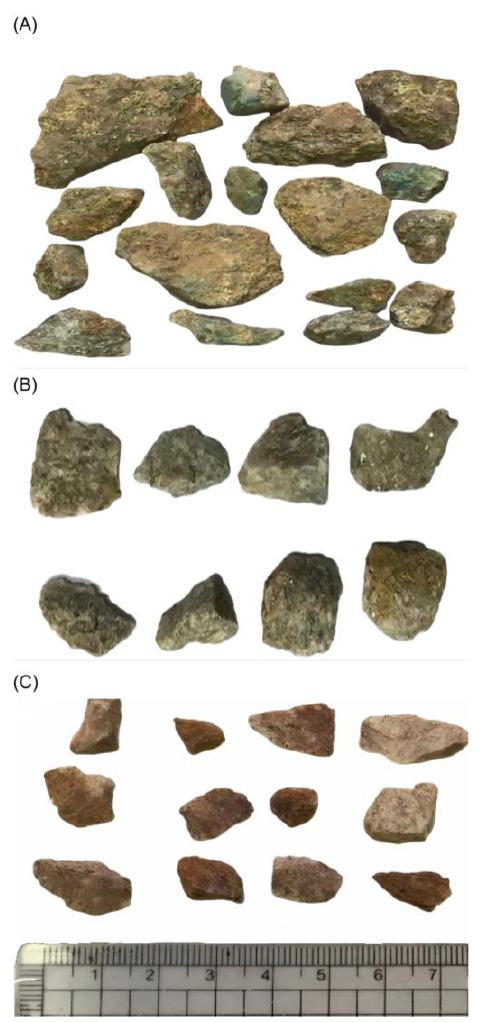
Figure 4. Fragment rocks from the investigated gold mines; Sukari ( A ), younger granite, Hamash ( B ), metavolcanic rocks, and Um Hagalig ( C ), younger granite.